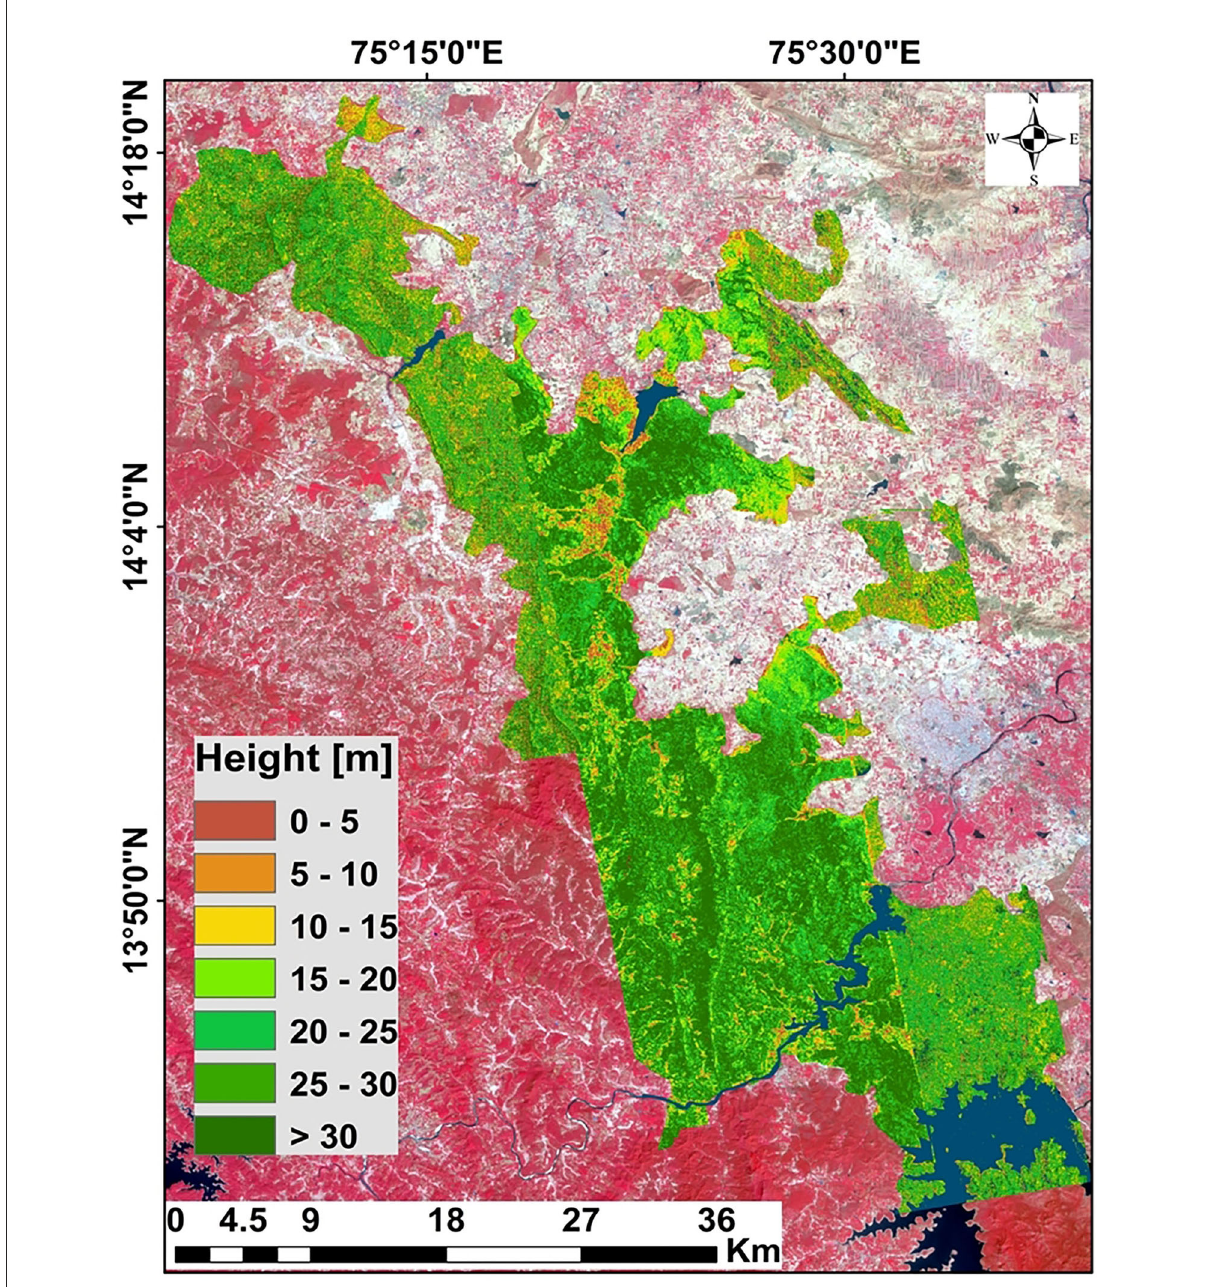
FIGURE10 Map of PolInSAR extracted heights over the Shimoga Forest extend. This map shows the mosaic of canopy heights of selected baselines overlaid on the Sentinel-2 optical image. Here, height maps of acquisitions that display good inversion accuracy are mosaicked together and masked by the desired forest